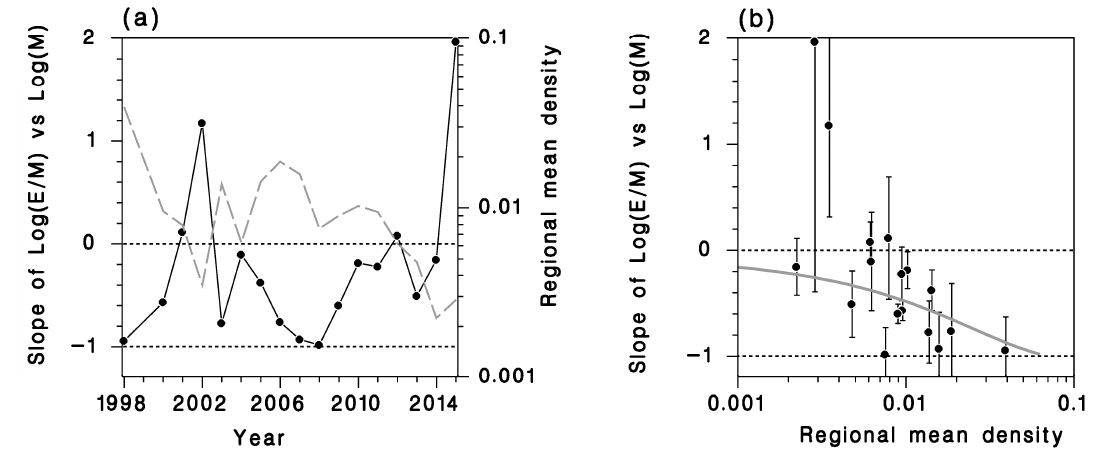
Figure 6. ( a ) Annual variation of the slope of the Log( E / M ) − Log( M ) regression (Equation (14), solid line and closed symbols) and of regional-mean adult density (dashed line) in southcentral British Columbia from 1998 to 2015. ( b ) Relationship between the slope of the Log( E / M ) − Log( M ) relationship and regional mean adult density. Vertical bars are SE of the parameter, solid grey line it the relationship expected from density-dependent emigration described by Equation (11) with α = 1, β = 0.26 and κ = 0.5, horizontal lines are two extreme cases: No migration ( α = 0) and panmixis ( α = 1).